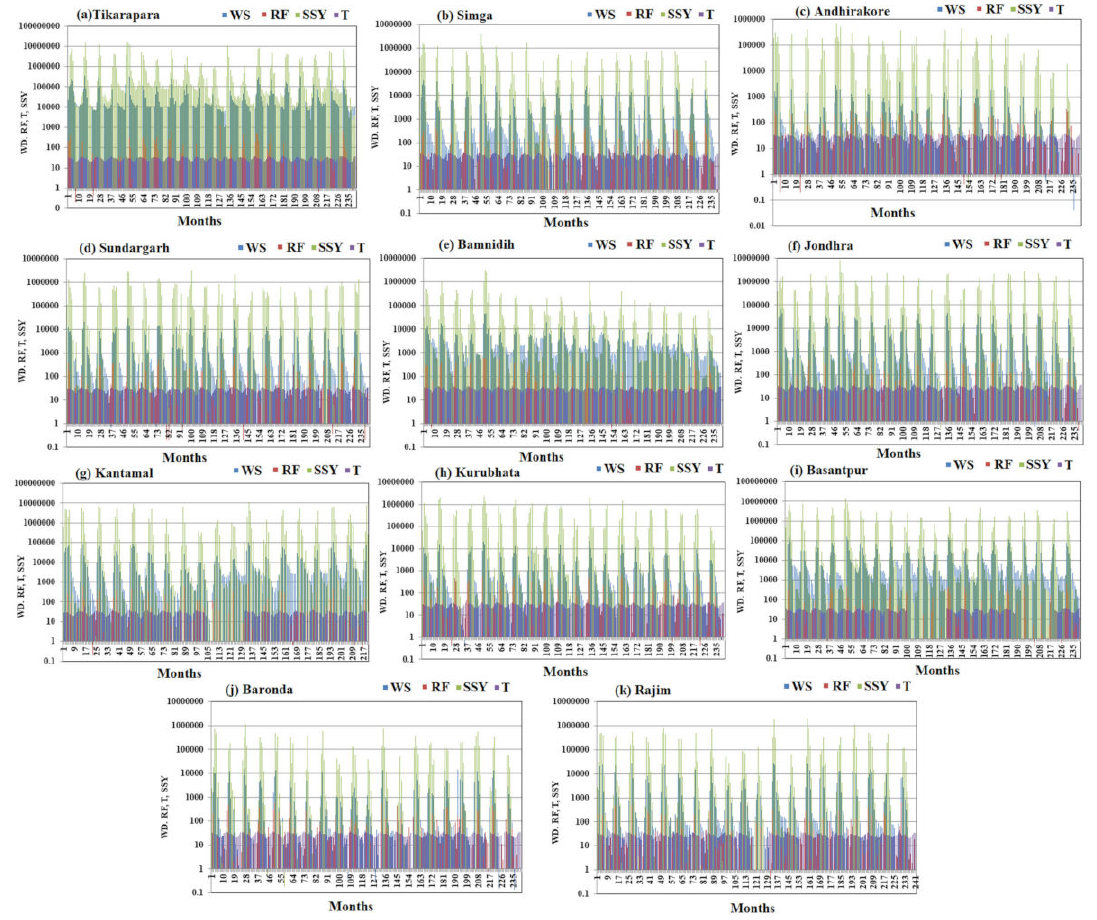
Figure 5. Monthly variations in WD, RF, T, and SSY at different locations ( a ) Tikarapara ( b ) Simga ( c ) Andhiyarakhore ( d ) Sundargarh ( e ) Bamnidih ( f ) Jondhra ( g ) Kantamal ( h ) Kurub-